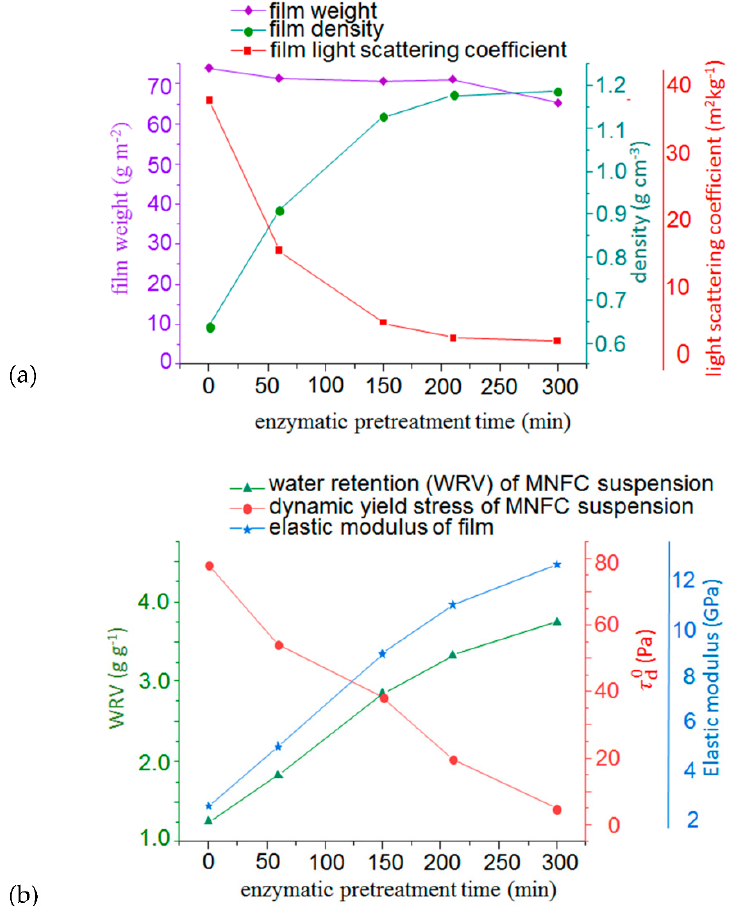
Figure 8. ( a ) Correlation between pulp enzymatic pretreatment hydrolysis time, film density and optical properties, and ( b ) between the water retention and dynamic rheological properties of the MNFC suspension, and the dried film elastic modulus.